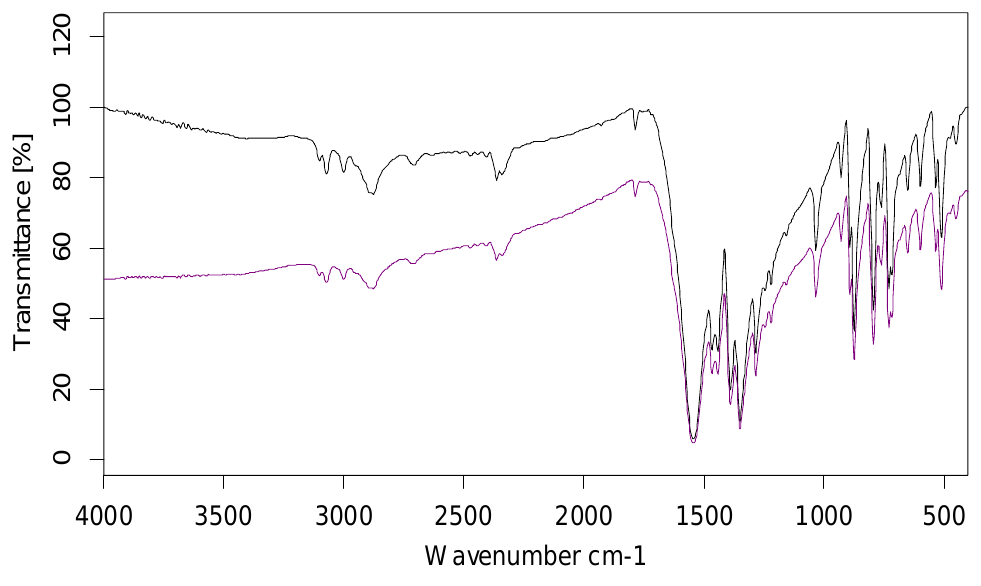
IR spectra of TPX and its decomposition residues, observed at room temperature (top) and 150 о C